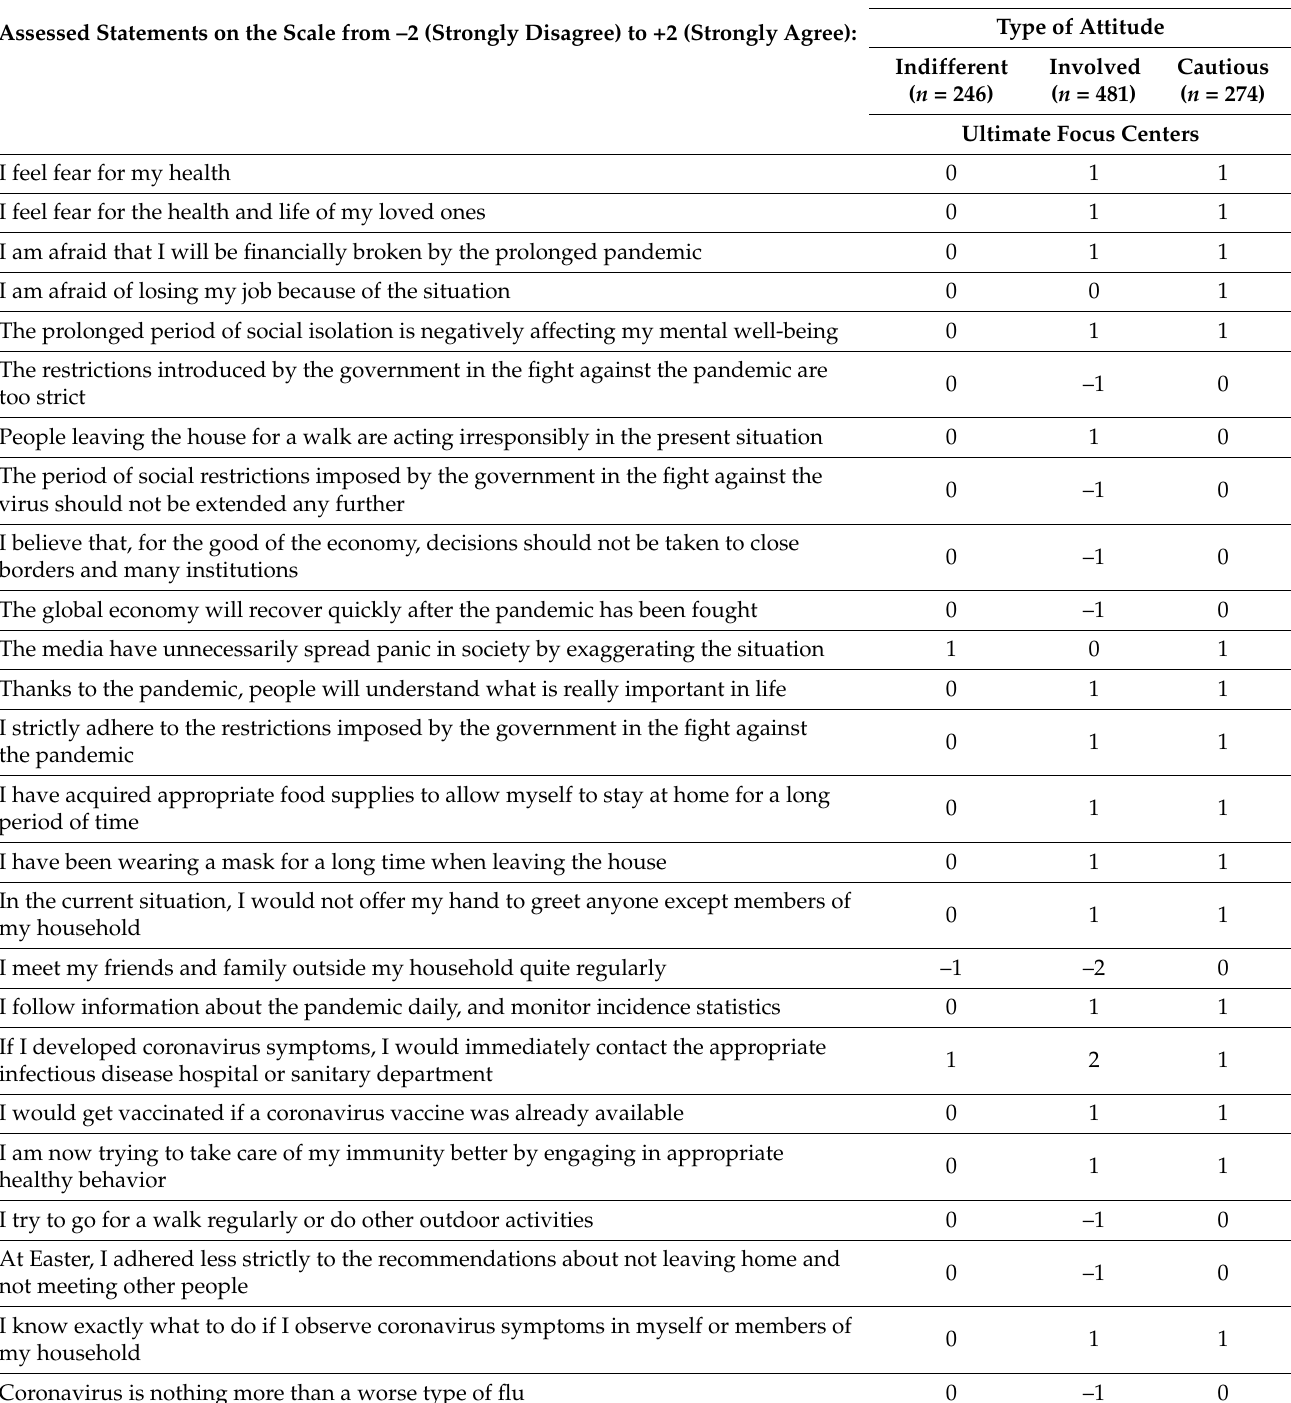
Table A2. Final cluster centers resulting from cluster analysis using the k-means method (scale from –2 to